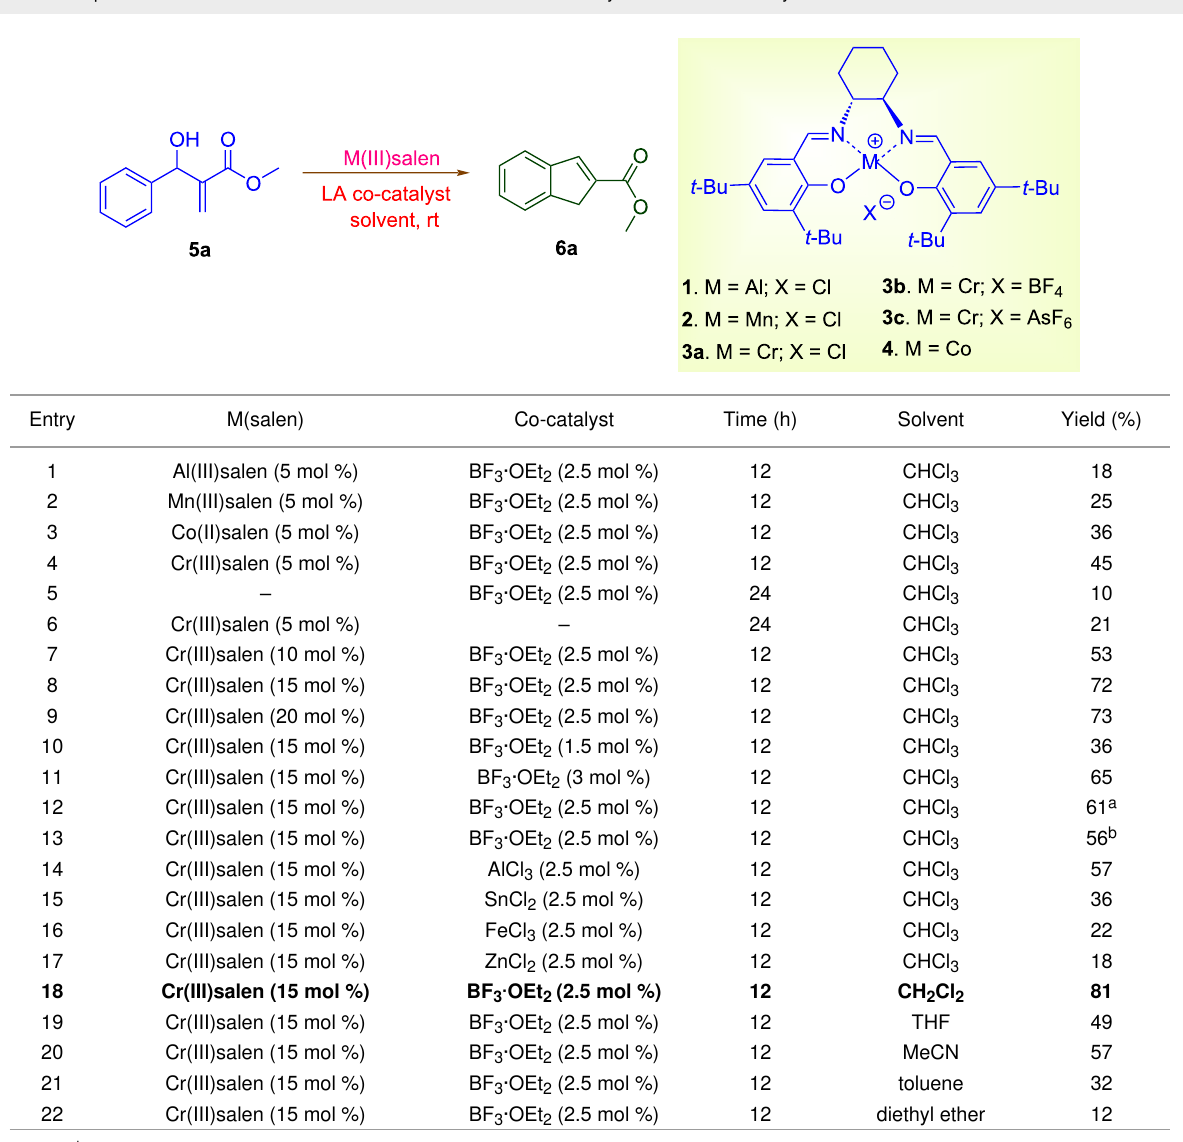
Table 1: Optimization of reaction condition for intramolecular Friedel–Crafts cyclization in Morita–Baylis–Hillman